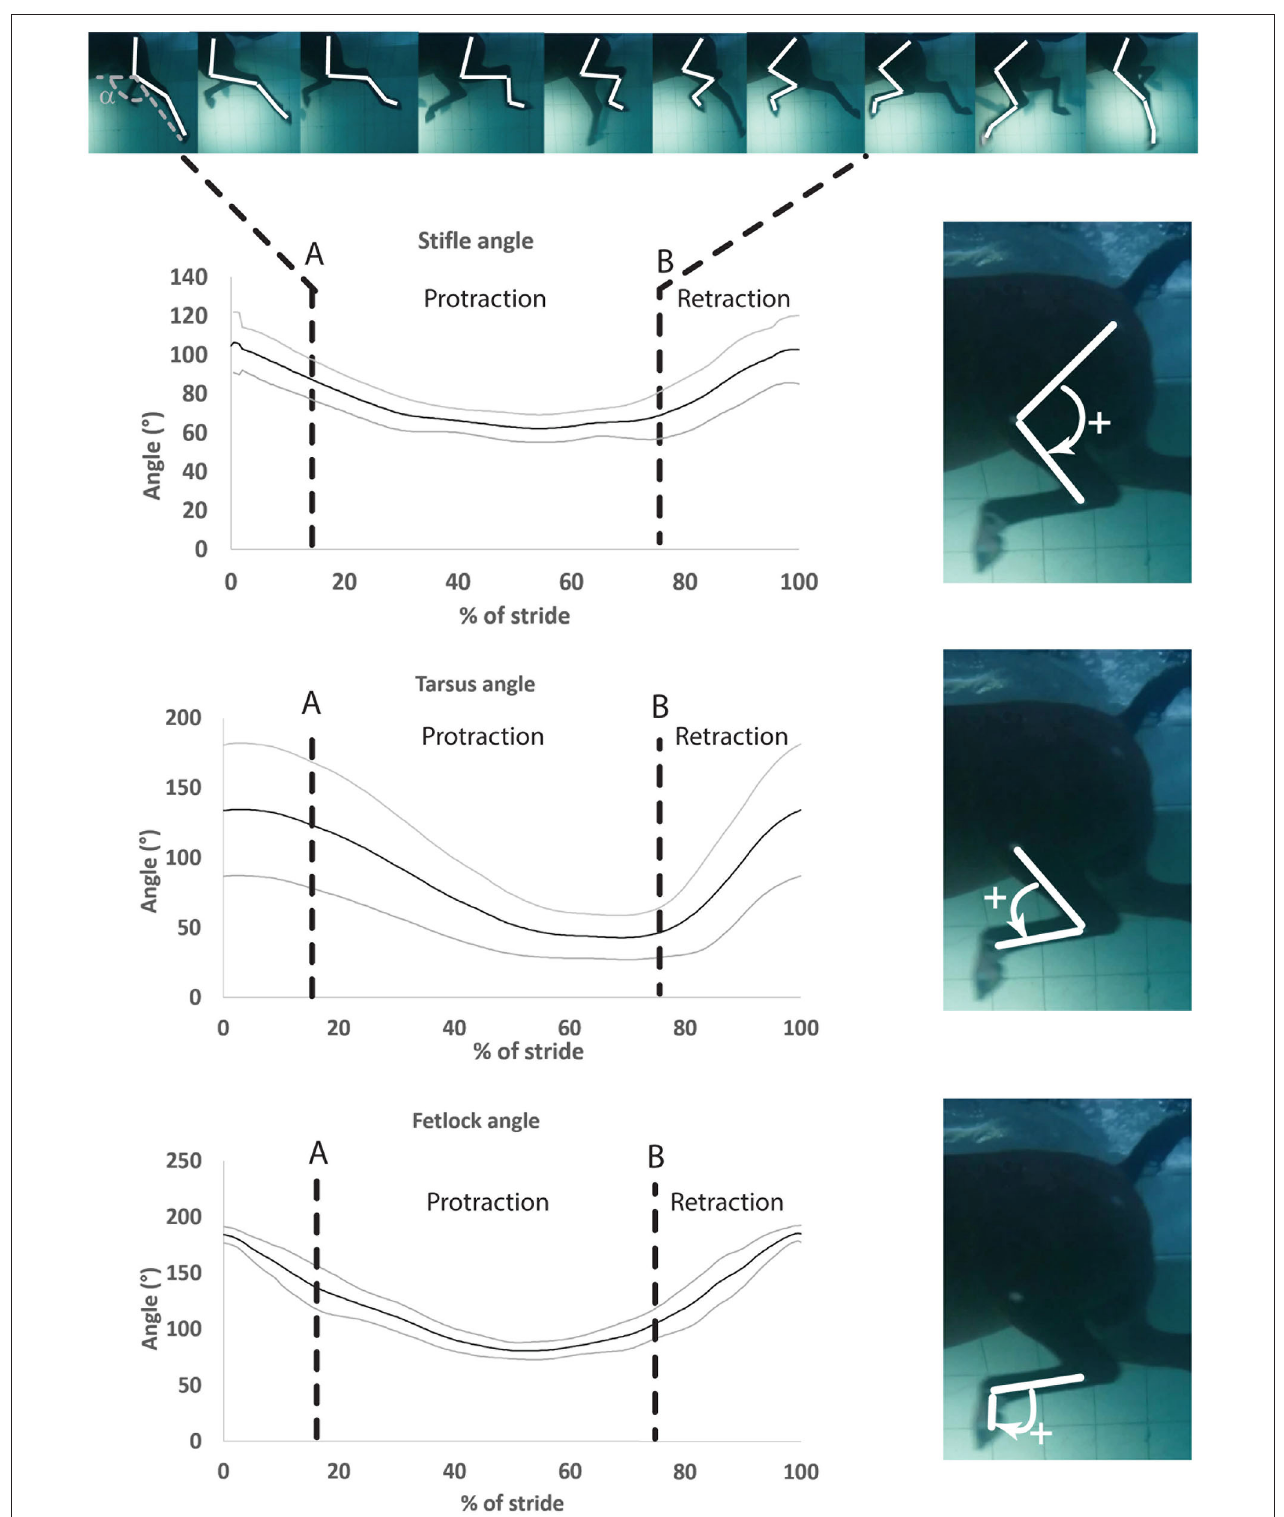
FIGURE 3 | Mean ± SD of the stifle, hock, and fetlock joint angles during a complete swimming stride (protraction and retraction). A, Start of protraction phase; B, Start of retraction phase; α , protraction–retraction angle. The arrow indicates the flexion of the joint of interest on the side illustration.